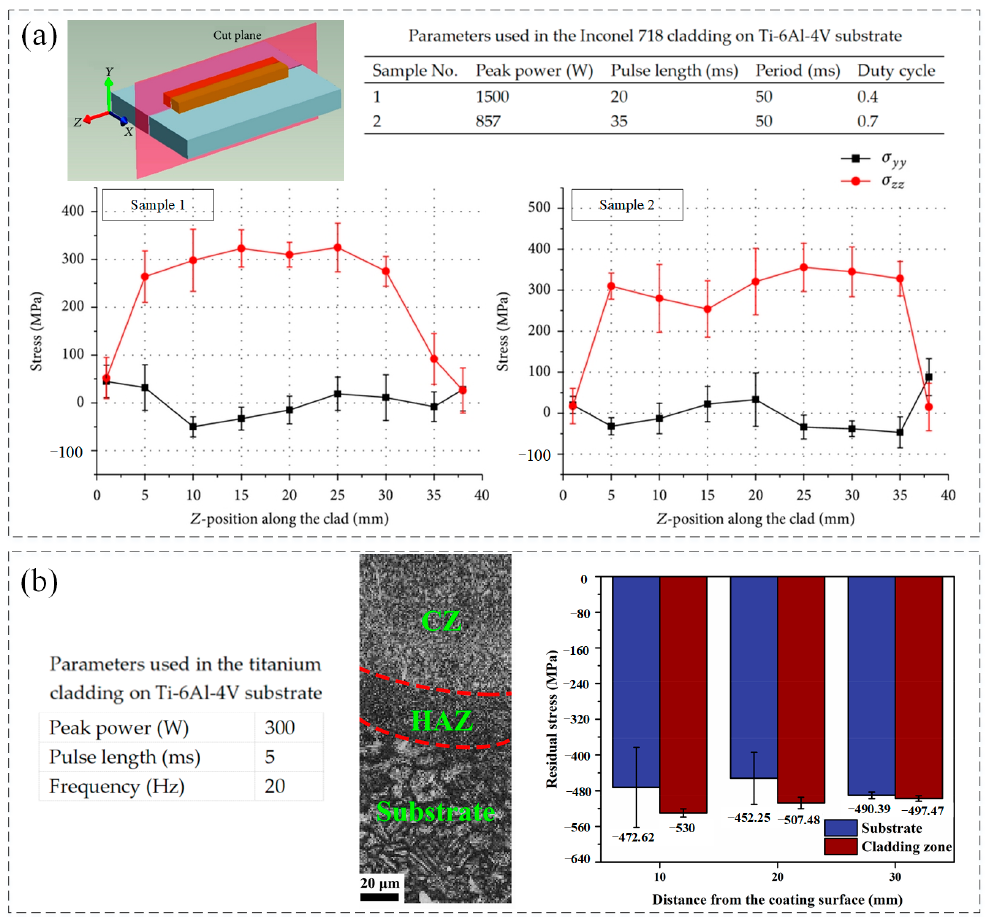
Figure 9. ( a ) Residual stress of Inconel 718 cladding creased by different parameters of PW laser (Re- printed from ref. [31], copyright (2014), with permission from Hindawi.); ( b )Residual stress of sub- strate and coating zone. (Reprinted from ref. [47], copyright (2021), with permission from Elsevier).